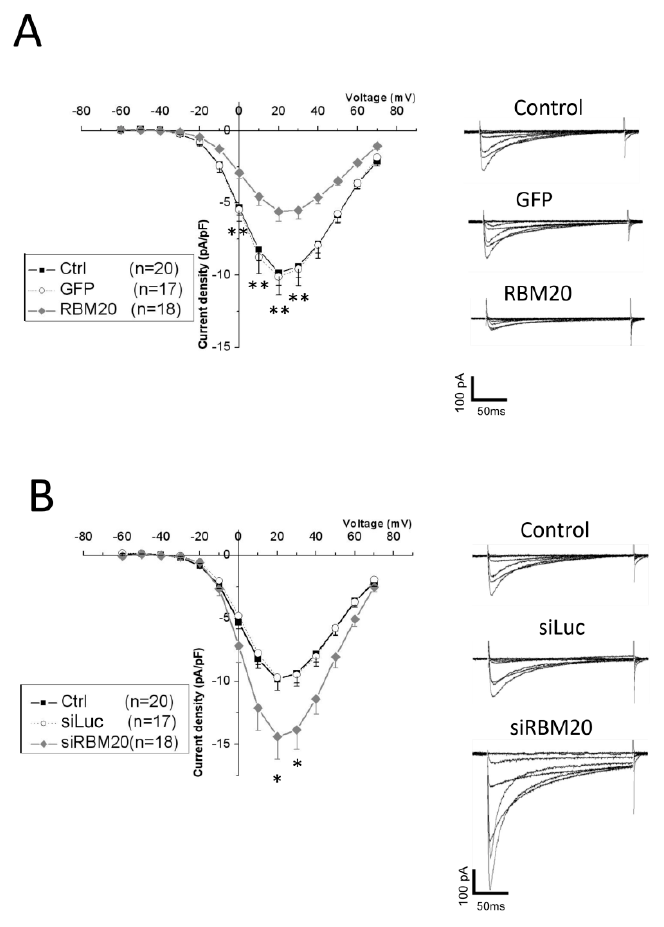
Figure 4. Manipulation of RBM20 expression altered l -type calcium currents in cardiomyocytes. ( A ) L -type Ca 2+ current-density—voltage curves recorded by patch clamp in the whole-cell configuration, from a − 40 mV holding potential with a 10 mV voltage step ranging from − 60 to + 70 mV. Currents were measured in control (black square), GFP (open circle), and RBM20-overexpressing (gray diamond) cardiomyocytes. The number of measured cells is indicated in the figure inset. Data are mean and SEM; ** is p < 0.01. Recorded traces on the right show an example of recorded calcium current traces in control (ctrl), GFP, and RBM20-overexpressing cardiomyocytes with current and time scale bars. ( B ) l -type Ca 2 + current-density–voltage curves recorded by patch clamp in the whole-cell configuration, from a − 40 mV holding potential with a 10 mV voltage step ranging from − 60 to + 70 mV. Currents were measured in control (black square), luciferase-1-targeting siRNA (open circle), and RBM20 siRNA (gray diamond) cardiomyocytes. The number of measured cells is indicated in the figure inset. Data are mean and SEM; * is p < 0.05. Recorded traces on the right show an example of the recorded calcium current traces in control (ctrl), luciferase-1-targeting siRNA (siLuc), and RBM20 siRNA (siRBM20) with current and time scale